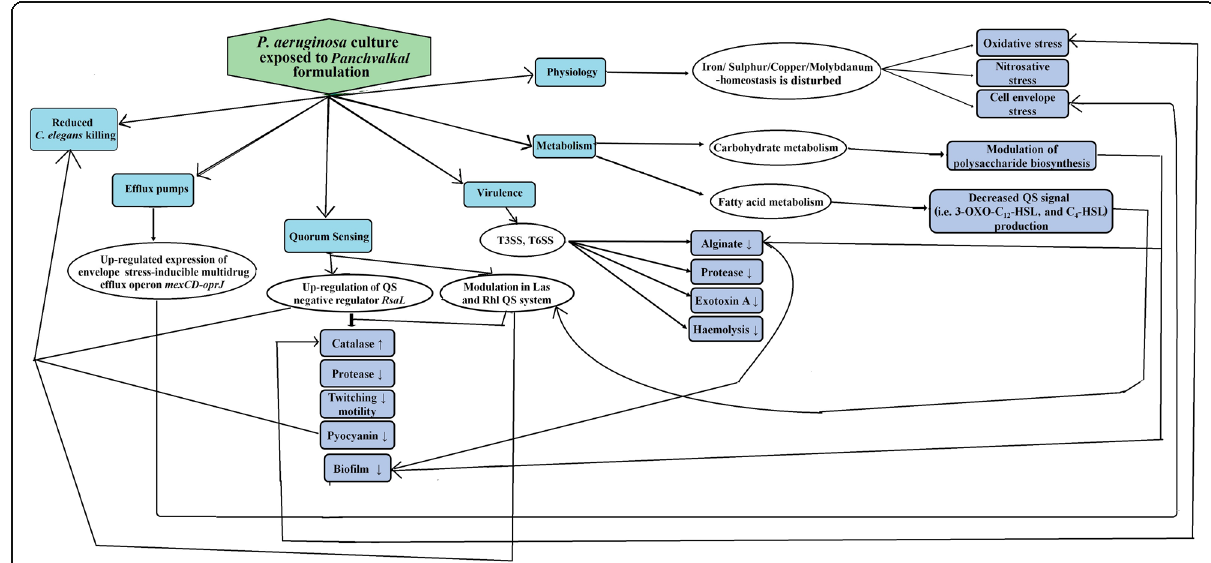
Fig. 4 Overall schematic explaining the anti-infective effect of Panchvalkal on P. aeruginosa. PF acts as an effective QSM against P. aeruginosa. It seems to induce oxidative and nitrosative stress in this pathogen, besides disturbing iron- and molybdenum- homeostasis, curbing down